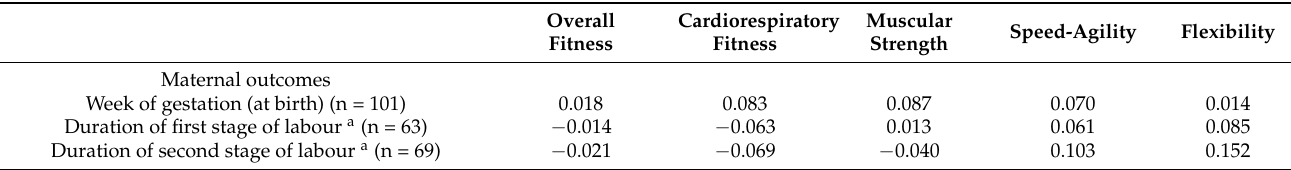
Table 2. Partial correlations of self-reported physical fitness component levels at 34th gestational week with maternal and neonatal birth